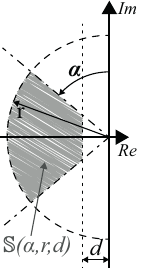
Figure 1. Region desired S ( α , r , d ) on complex plane.